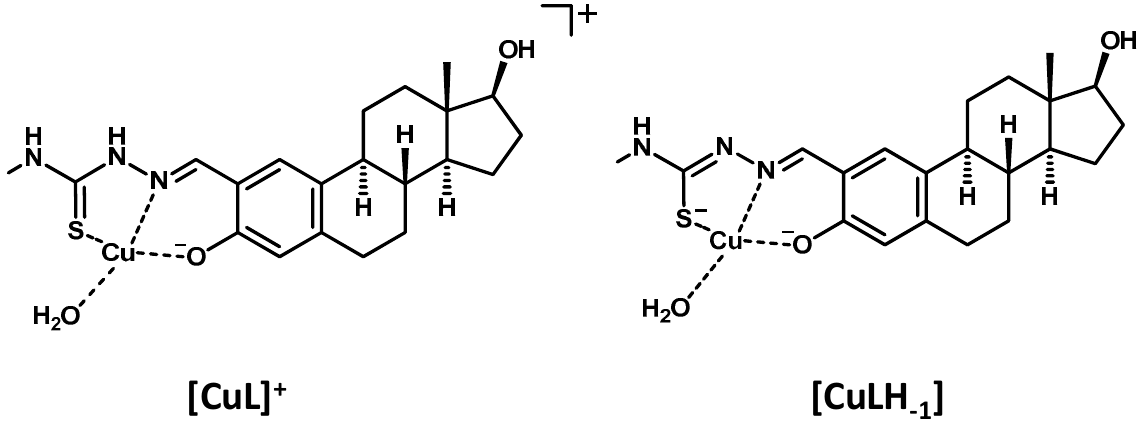
[CuL] + [CuLH ] ‐1 Scheme 2. Suggested structures for the Cu(II) complexes formed with Me-estadiol-TSC. Scheme 2. Suggested structures for the Cu(II) complexes formed with Me ‐ estadiol ‐ TSC. Overall stability constants for complexes [CuL] + and [CuLH − 1 ] were computed by the evaluation of the UV–vis spectra obtained at various pH values (Table 2, and for the individual molar absorbance spectra, see Figure S5). Additionally, concentration distribution curves (Figure 2b, Figure S4b) were also computed using the stability constants. In order to compare the stability of the complexes, pCu values were also calculated at pH 5 and at 20 µ M concentrations of both the ligand and the metal ion using the overall stability constants (Table 2). pM values at pH 6.0 and 7.4 were also estimated for better interpretation of the obtained results, which will be further used in Section 2.6 (Table 2). pCu is the negative decadic logarithm of the unbound metal ion concentration under chosen conditions and provides a solid basis for comparison of the stability of the complexes.